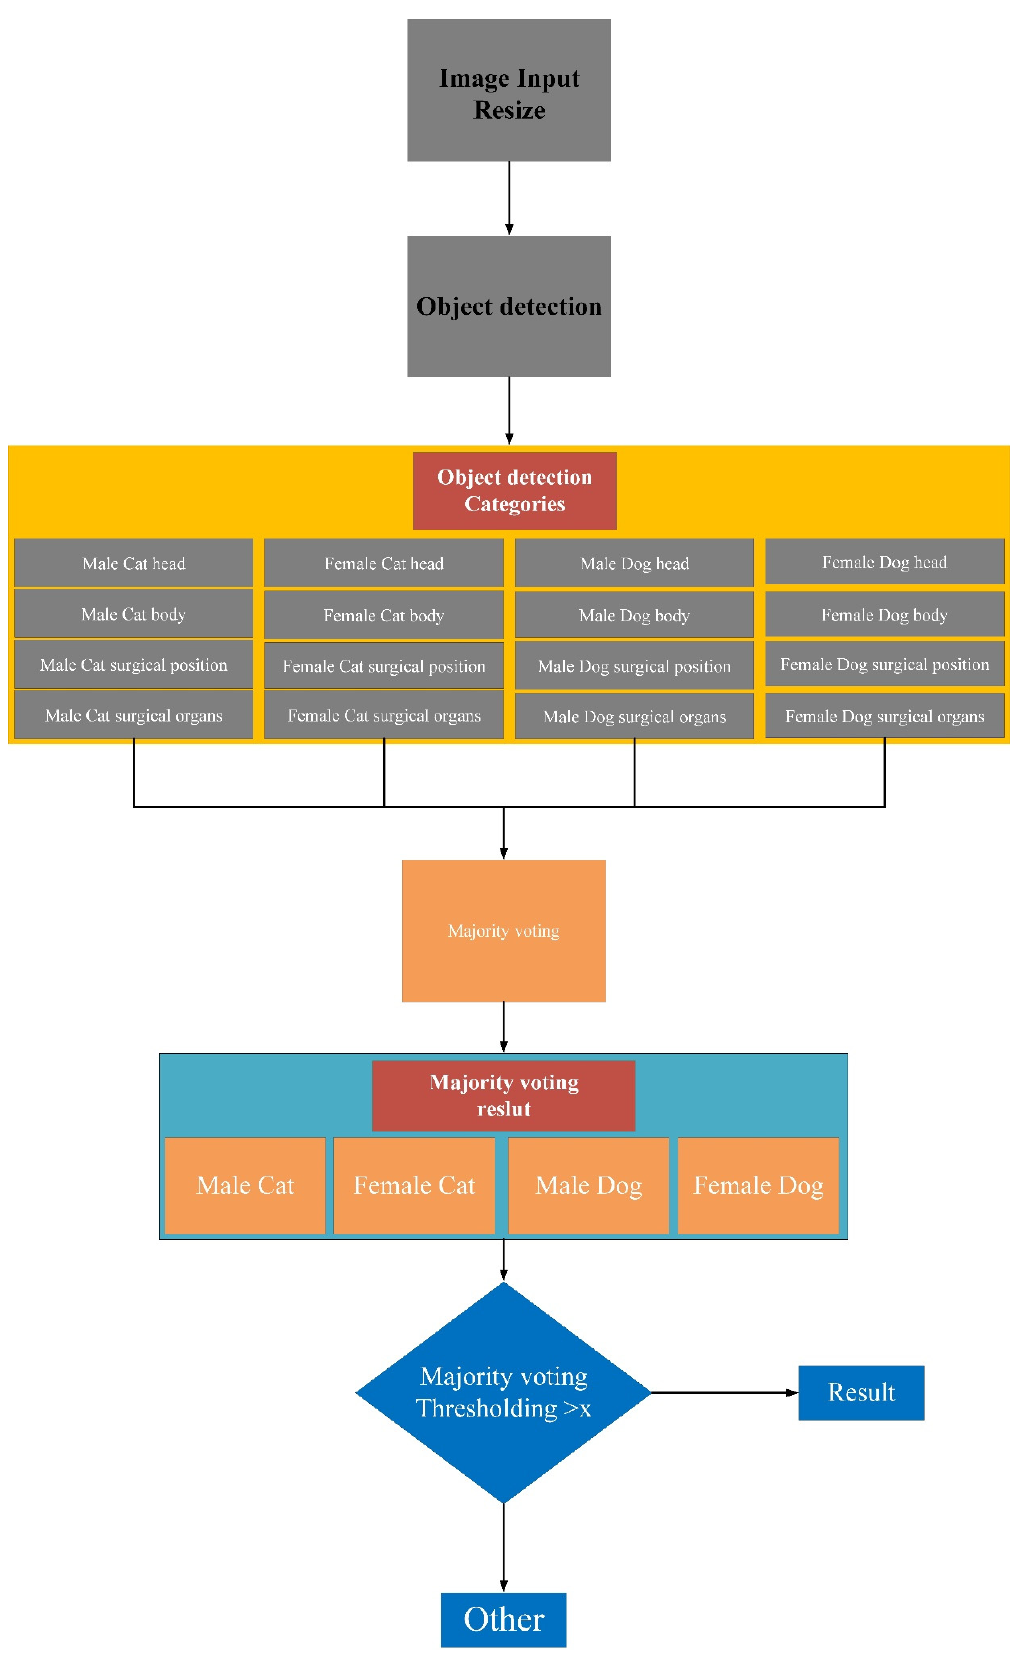
Figure 10. Operation process of Yolo-Based Deep Learning Integrated with Majority Voting System.